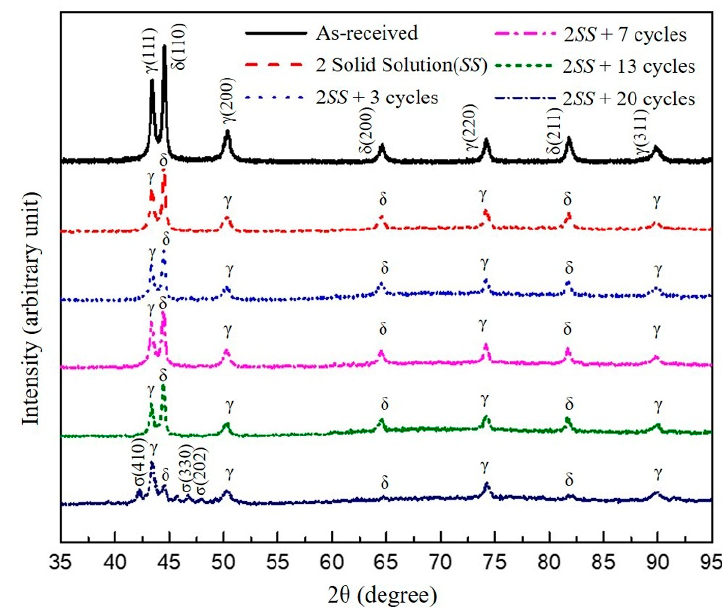
Figure 3. Analysis of X-ray di ff raction patterns for various thermal cycling processes.